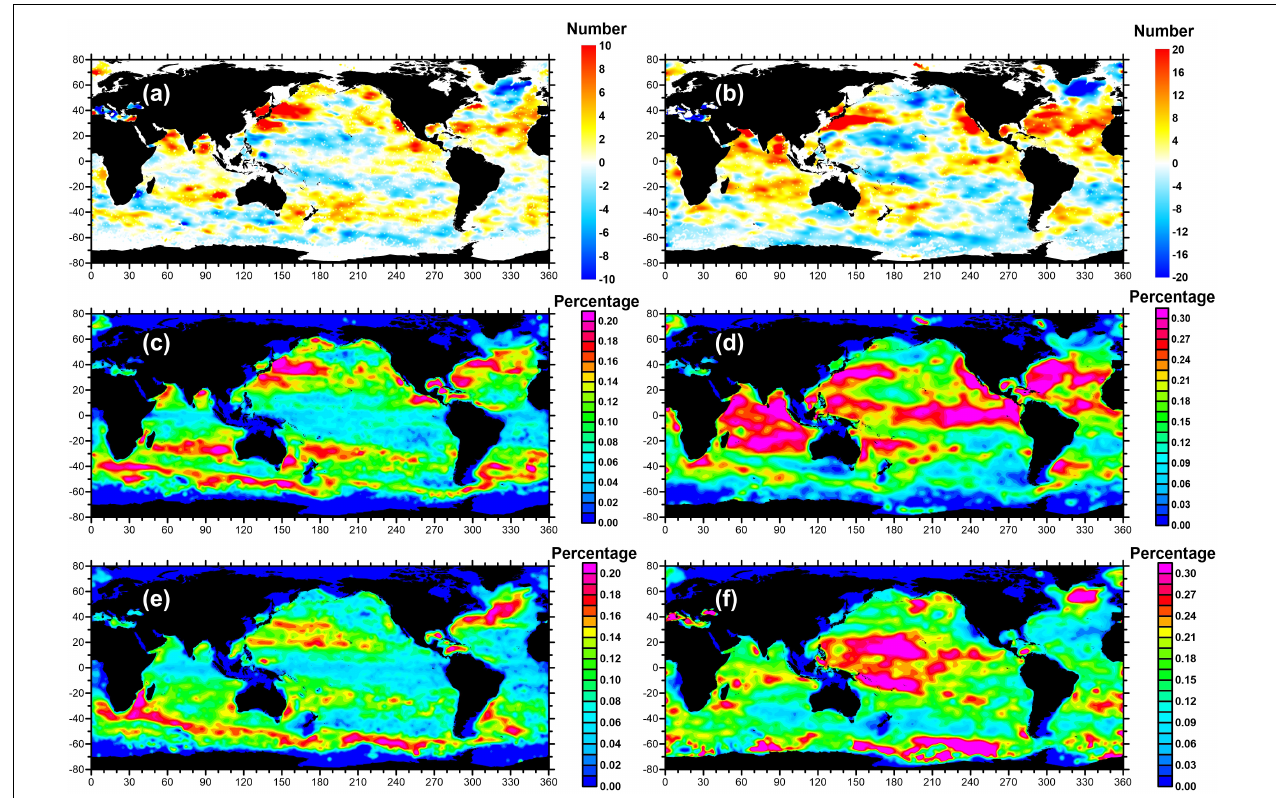
FIGURE 8 | Global geographic distribution of Argo profile density per 1 ◦ × 1 ◦ grid during 2002 to 2019. (a) Distribution of numbers of Argos in Alt anticyclonic eddies (AE) minus the numbers of Argos in Alt cyclonic eddies (CE) in the corresponding grid. (b) Same as Panel (a) but is the Argos in CNN-XGB eddies. (c,d) The frequencies of Argo profiles in Alt AE and CNN-XGB AE occurrence with respect to all Argo profiles within the same grid, respectively. ( e,f ) same as Panels (c,d) but for